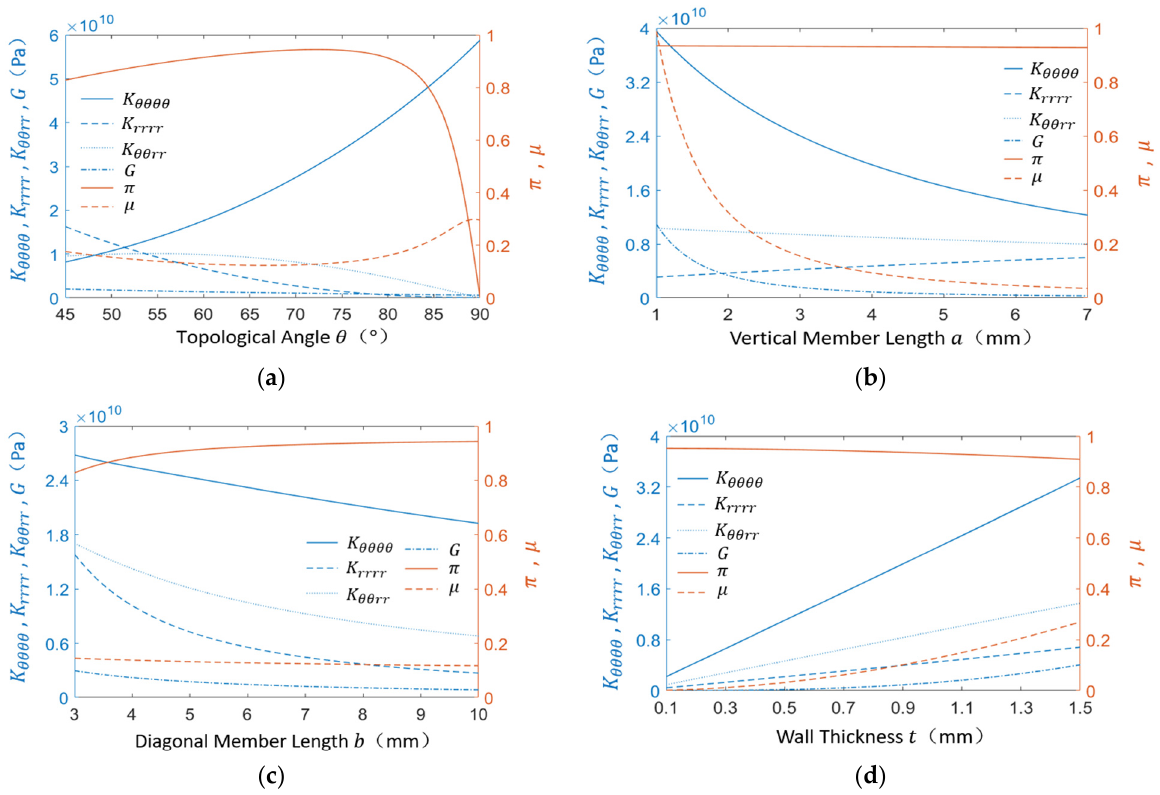
Figure 11. Effects of cellular structure parameters on pentamode characteristic parameters. ( a ) Effect of topological angle 𝜃 ; ( b ) effect of vertical member length 𝑎 ; ( c ) effect of diagonal member length 𝑏 ; and ( d ) effect of wall thickness 𝑡 .